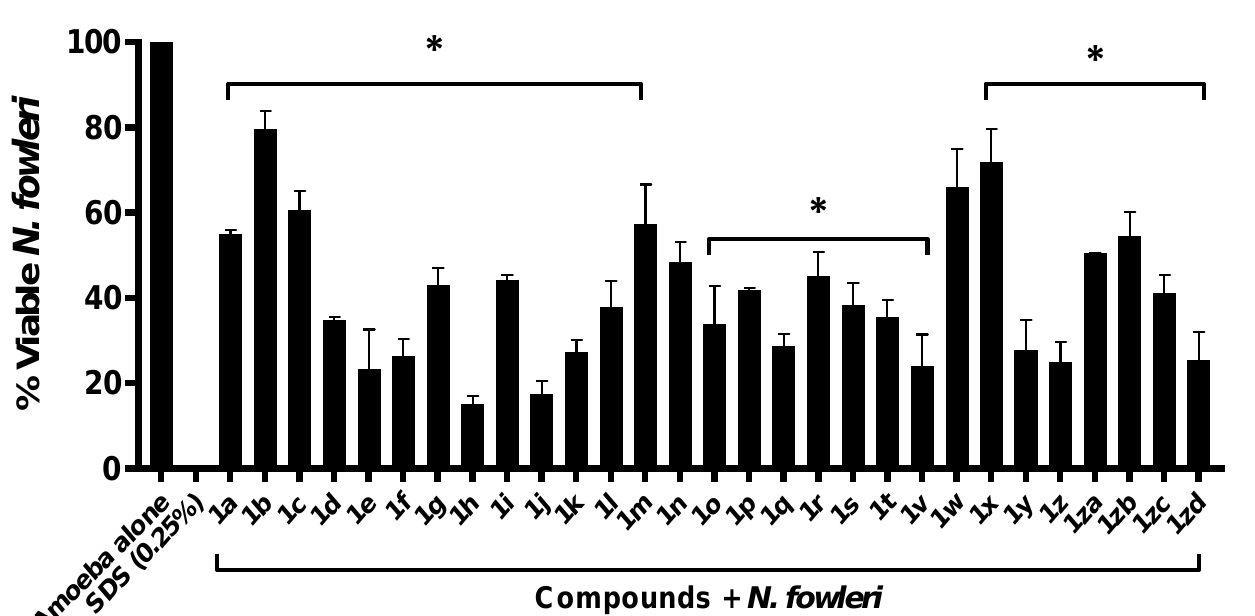
Figure 1. The majority of drugs exhibited significant amoebicidal properties against Naegleria fowleri. Significant anti-amoebic effects were found for the majority of compounds against N. fowleri after a 24 h incubation period. The data are illustrative of independent experiments performed and are presented with a mean ± standard error. Furthermore, the p -values were determined through the conduction of a two-sample t -test with two-tailed distributions (* is ≤ 0.05). Additionally, the minimum inhibitory concentrations required to inhibit 50% of N.